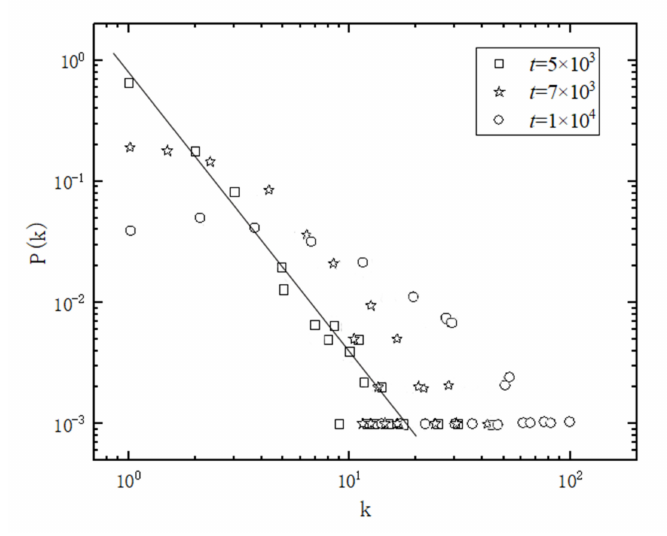
Figure 7. Evolution diagram of the network degree distribution under different time